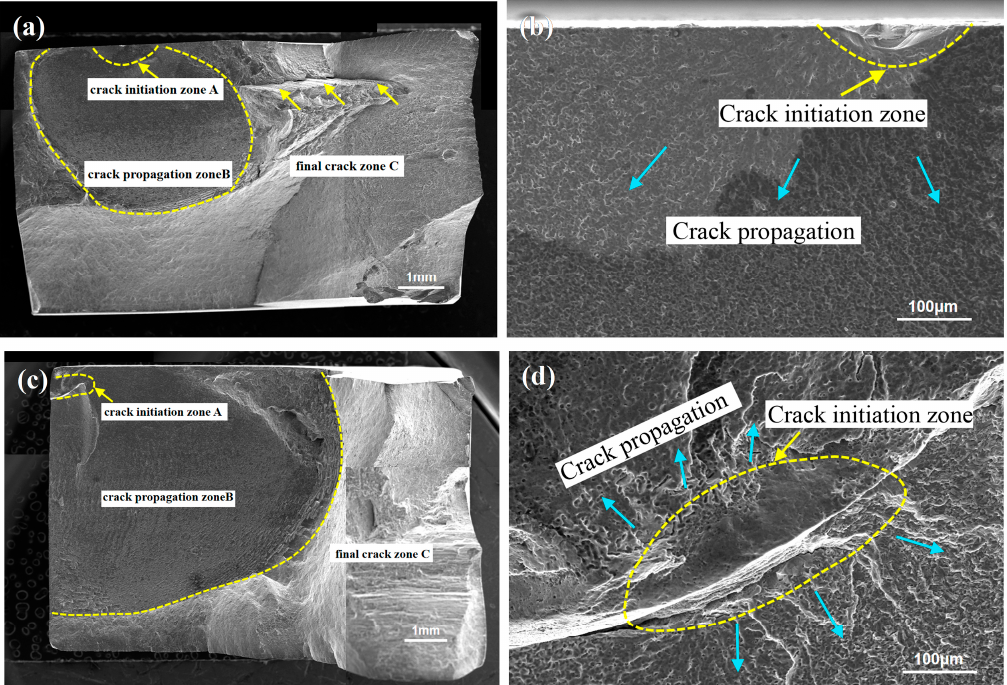
Figure 14. Fracture morphologies of the UAFSW specimens at maximum stresses of 230–225 MPa: ( a ) 230 MPa; ( b ) crack initiation zone from Figure 14a; ( c ) 225 MPa; and ( d ) crack initiation zone from Figure 14c.